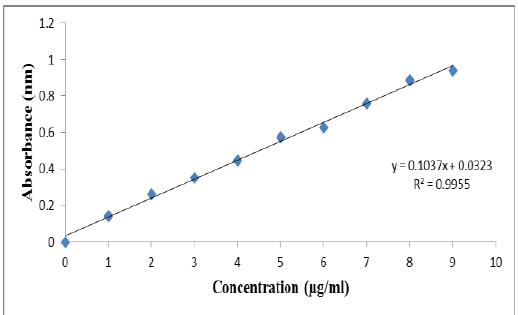
Figure (5) Calibration curve of rebamipide in